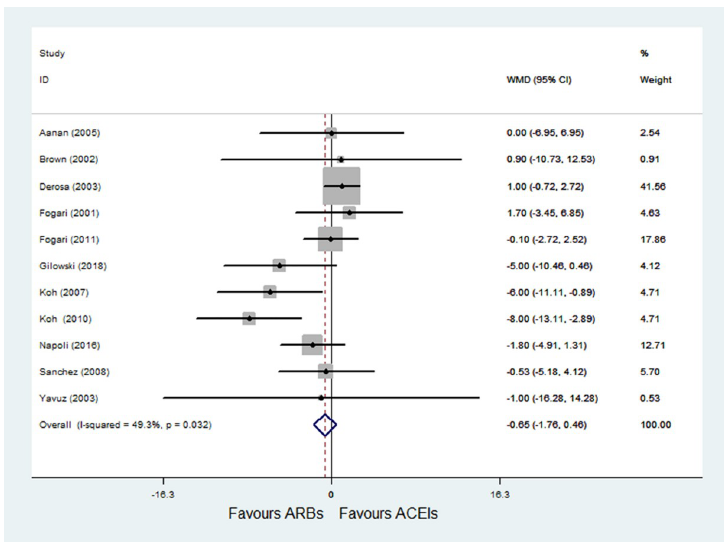
Fig 6. Effect of ARBs versus ACE inhibitors on systolic blood